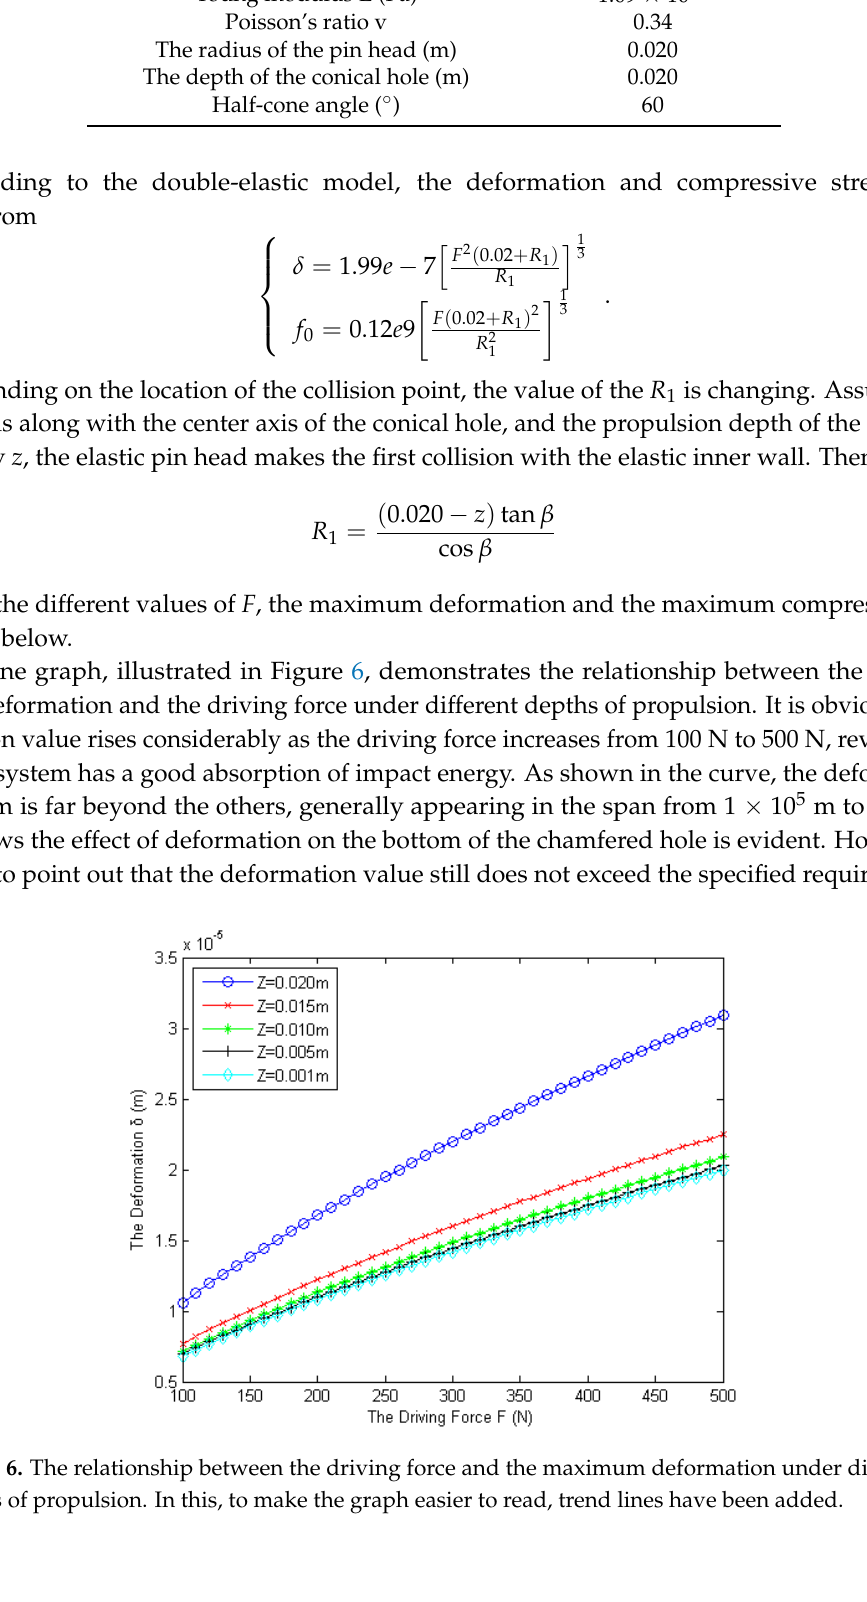
Table 1. The docking parameter specifications.